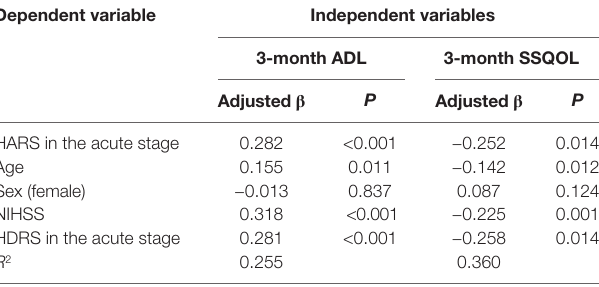
TABLE 5 | The effects of PSA in the acute stage on ADL and SSQOL at 3 months after